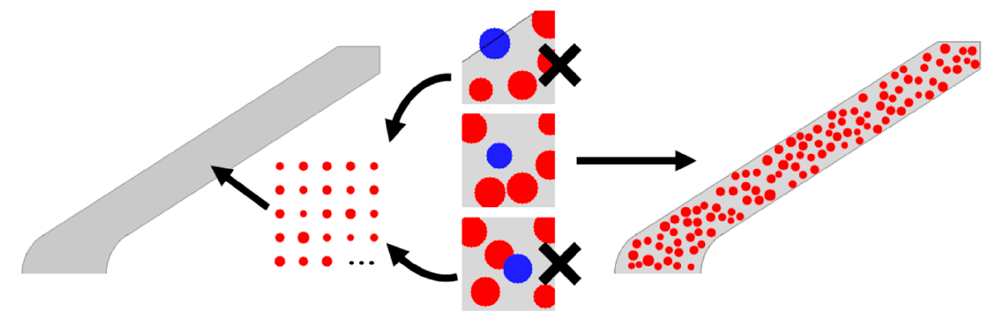
Figure 4. Generation process of typical PTFE-Al liner discretization model.